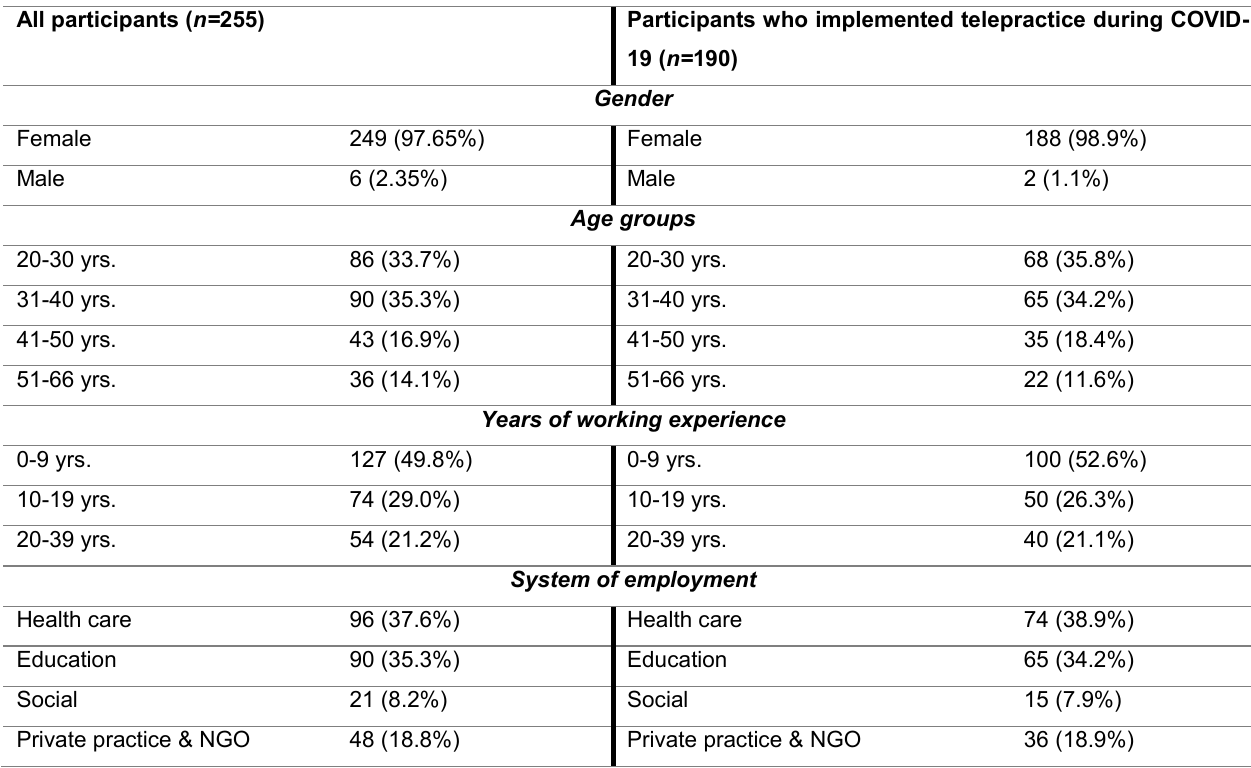
Table 1 Demographic Characteristics of all Survey Respondents (n=255) and of Those Whose Data Were Finally Analysed as